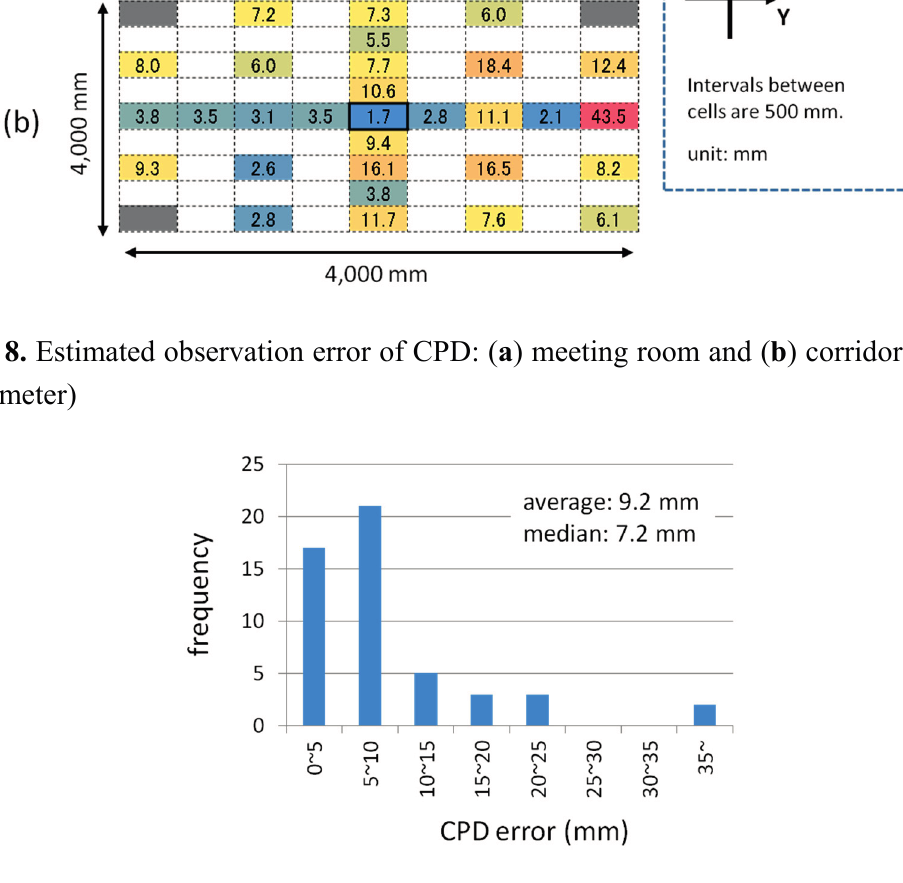
Figure 9. Histogram of estimated observation error of CPD for both meeting room and